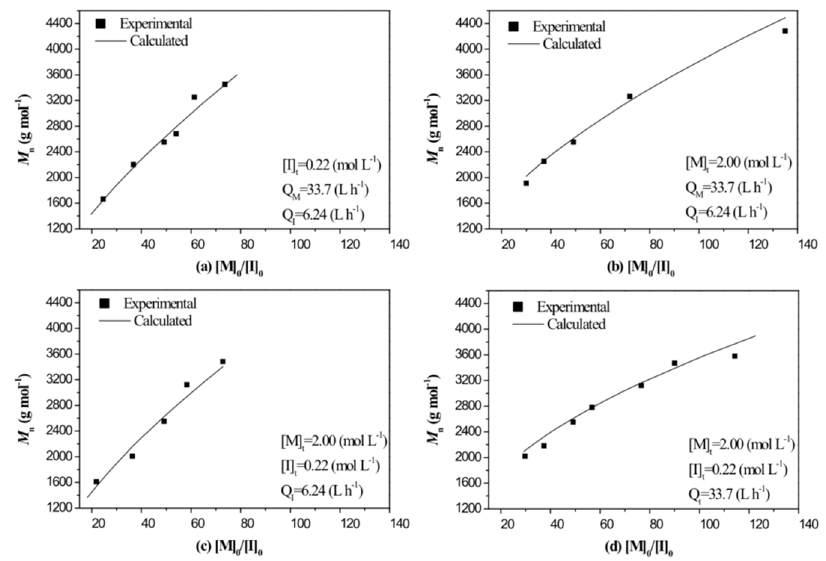
Figure 7. Effects of [M] 0 /[I] 0 on the M n of PIB when T = 283 K and N = 1600 rpm. The [M] 0 /[I] 0 was changed by ( a ) changing [M] t , ( b ) changing [I] t , ( c ) changing Q M and ( d ) changing Q I .